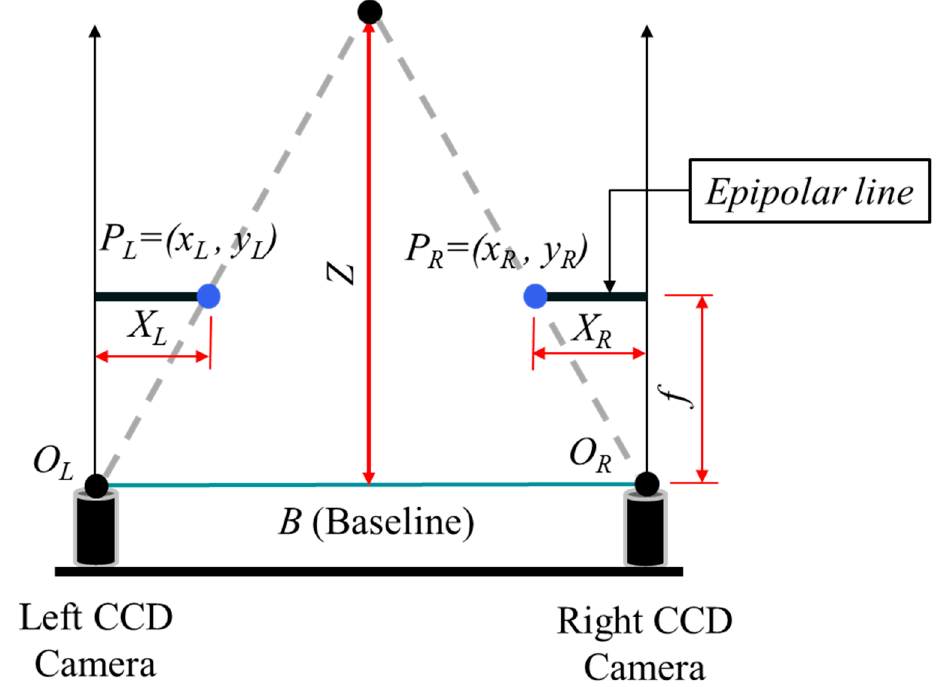
Figure 12. Determination of the distance between the cameras and the object in a space through epipolar geometry.